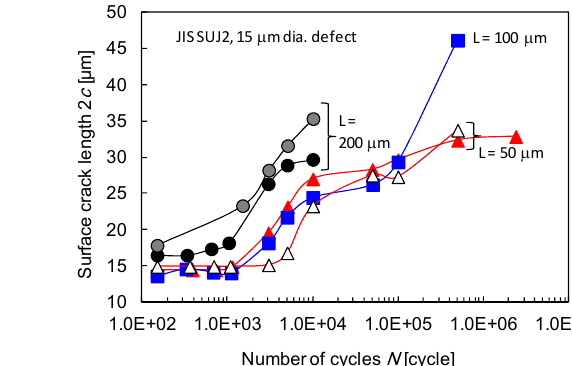
Figure 2: Changes in surface length of vertical crack including defect during RCF